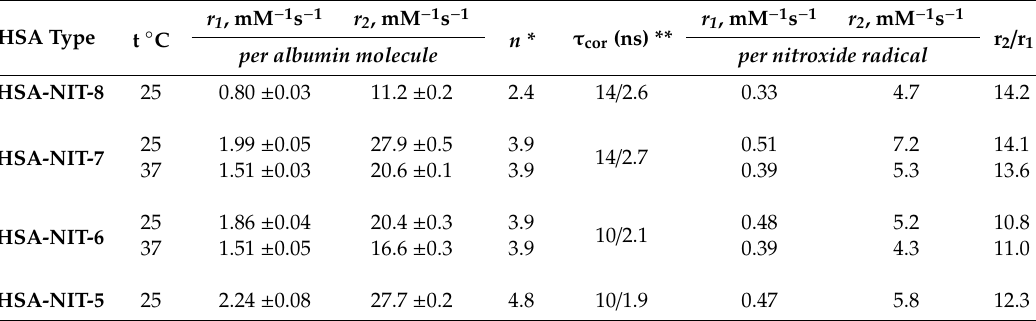
Table 4. Characterization of HSA-NIT conjugates’ magnetic properties at 7